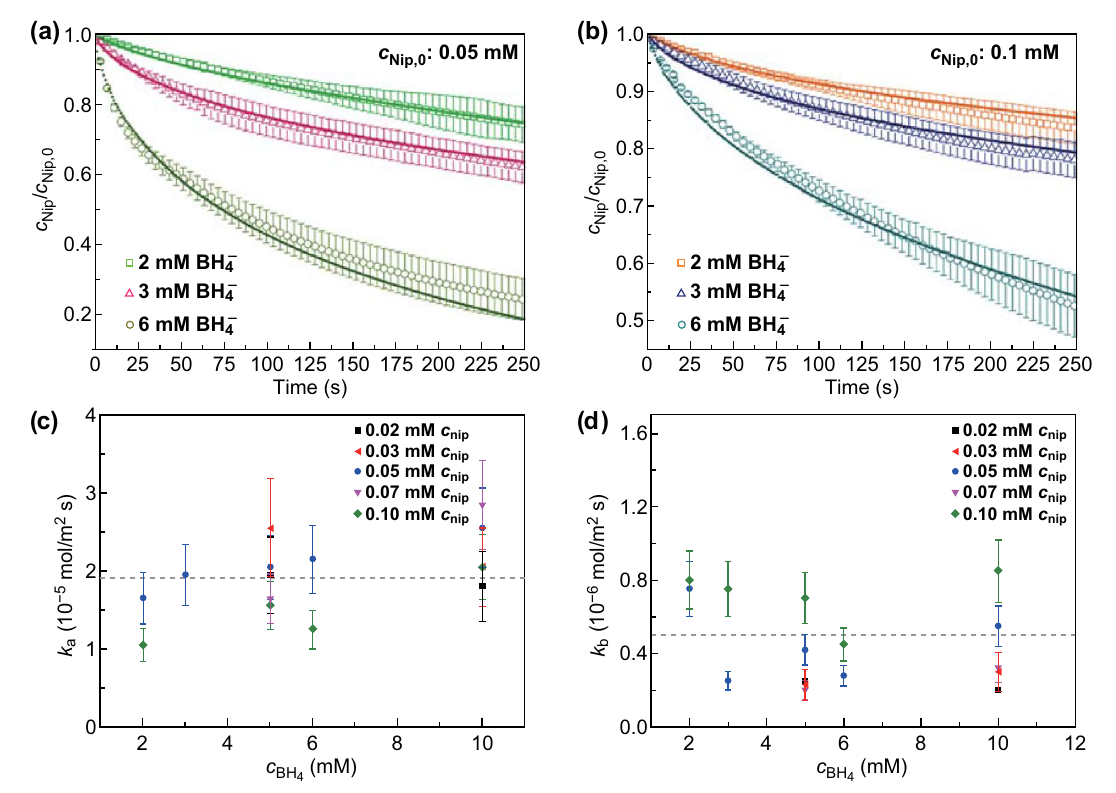
Fig. 6 a , b Fit of the concentration of 4‑nitrophenol as the function of time by the theoretical model. The concentration of 4‑nitrophenol was normalized to the respective starting concentration c Nip,0 . The experimental data have been taken from reactions at 20 °C (data points with error bars). The solid lines refer to the fits by the kinetic model. c, d Kinetic constants k a and k b derived from fitting results. The dash lines indicate the average values